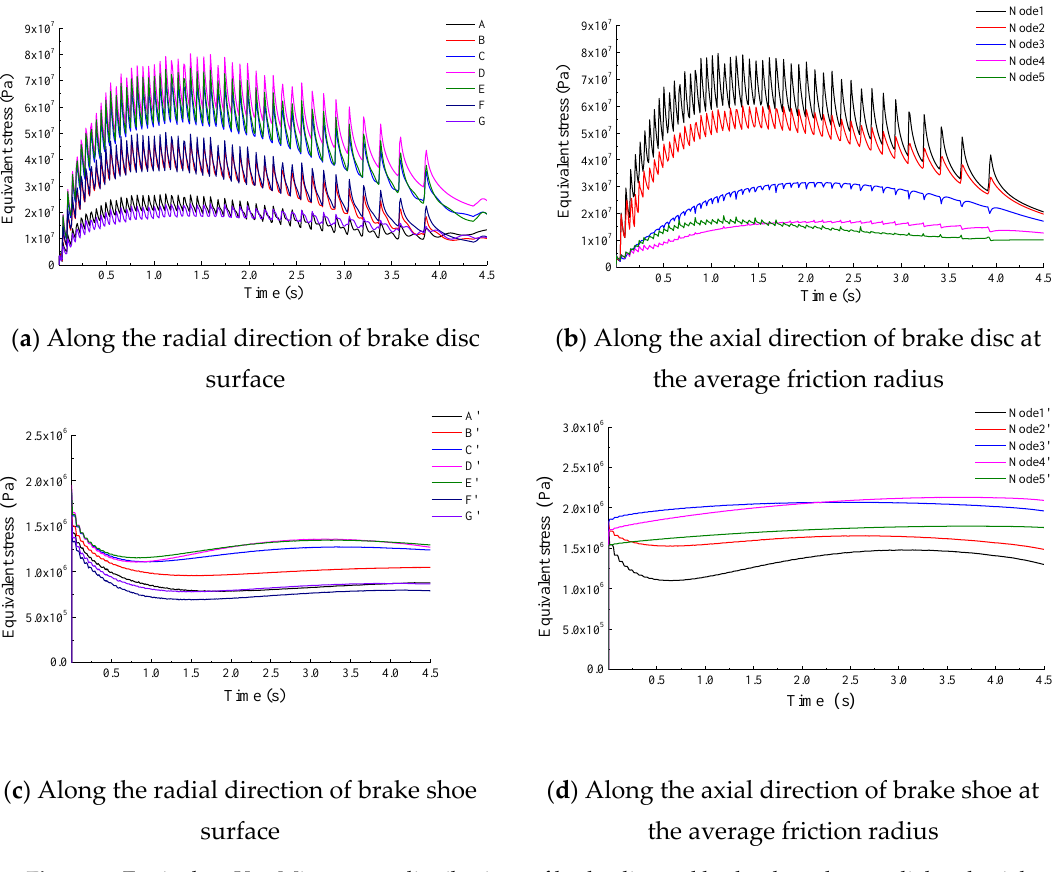
axial paths during emergency braking.